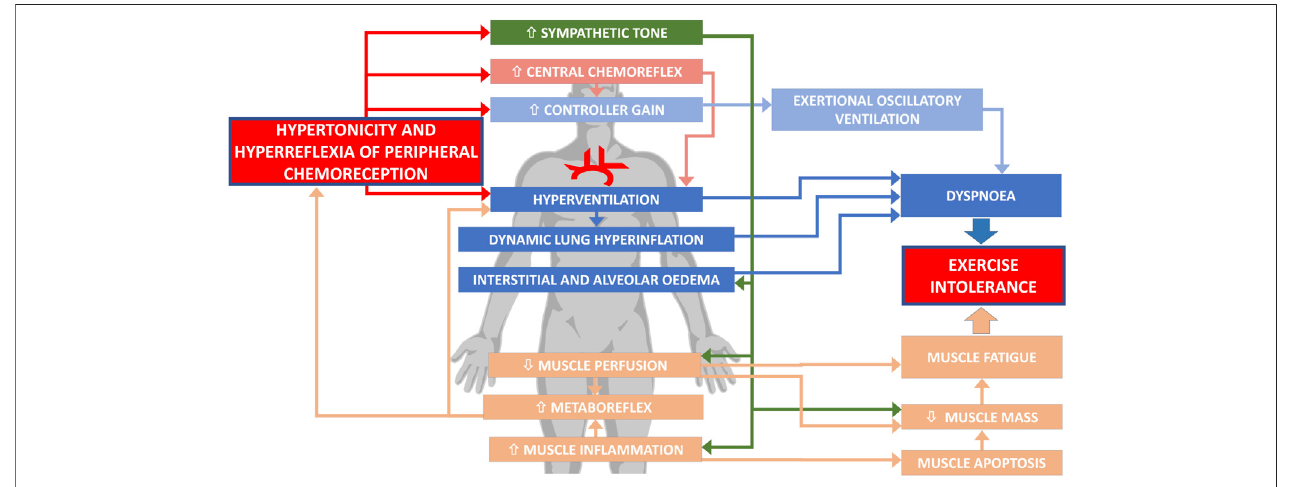
FIGURE 1 | Involvement of abnormal peripheral chemoreception in exercise intolerance in heart